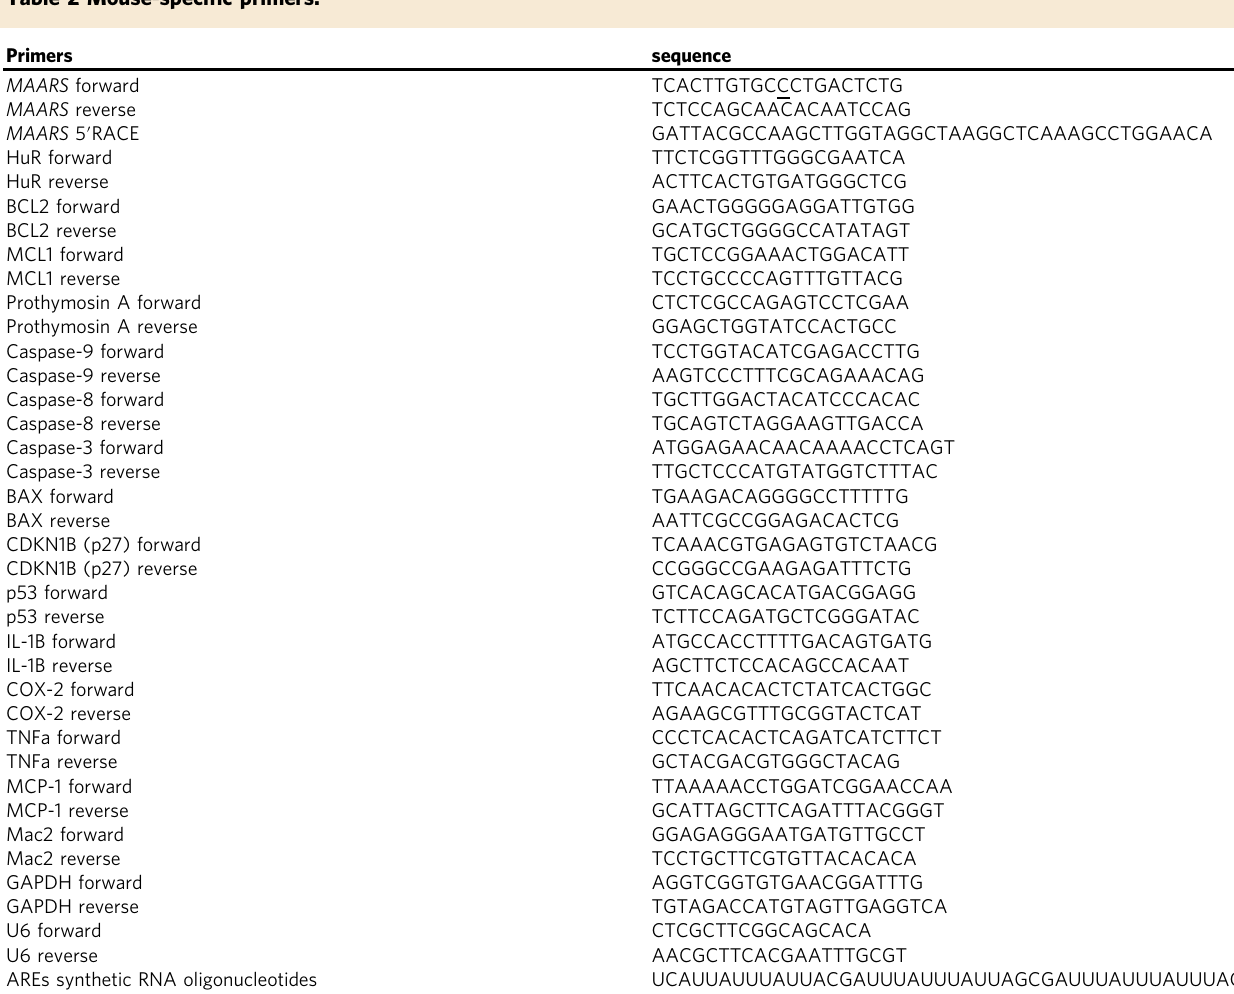
Table 2 Mouse-speci fi c primers. Primers